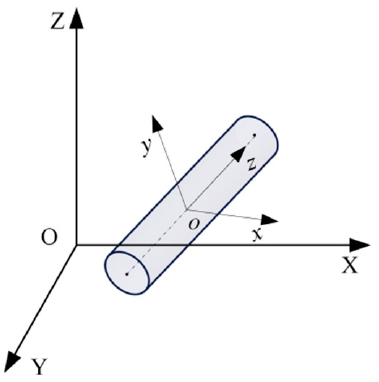
Figure 4. Local and global coordinate system for an element.